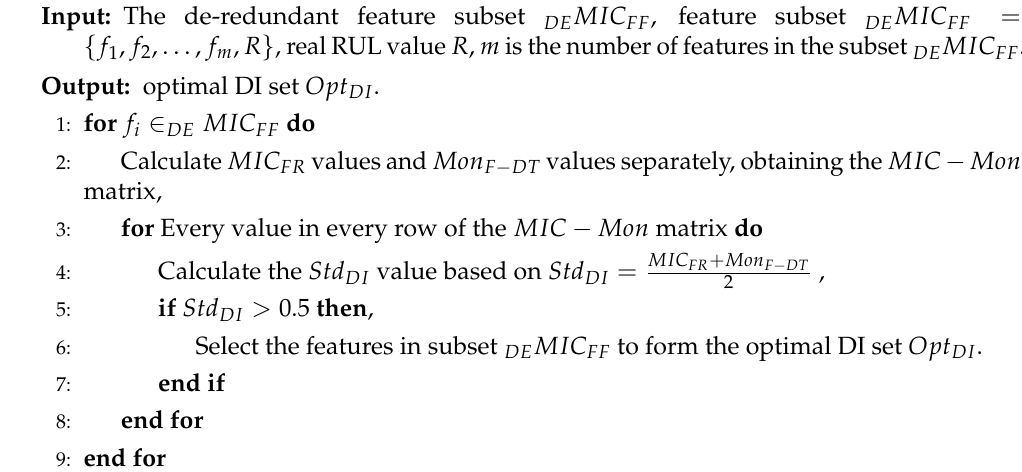
Algorithm 1 Optimal DI construction